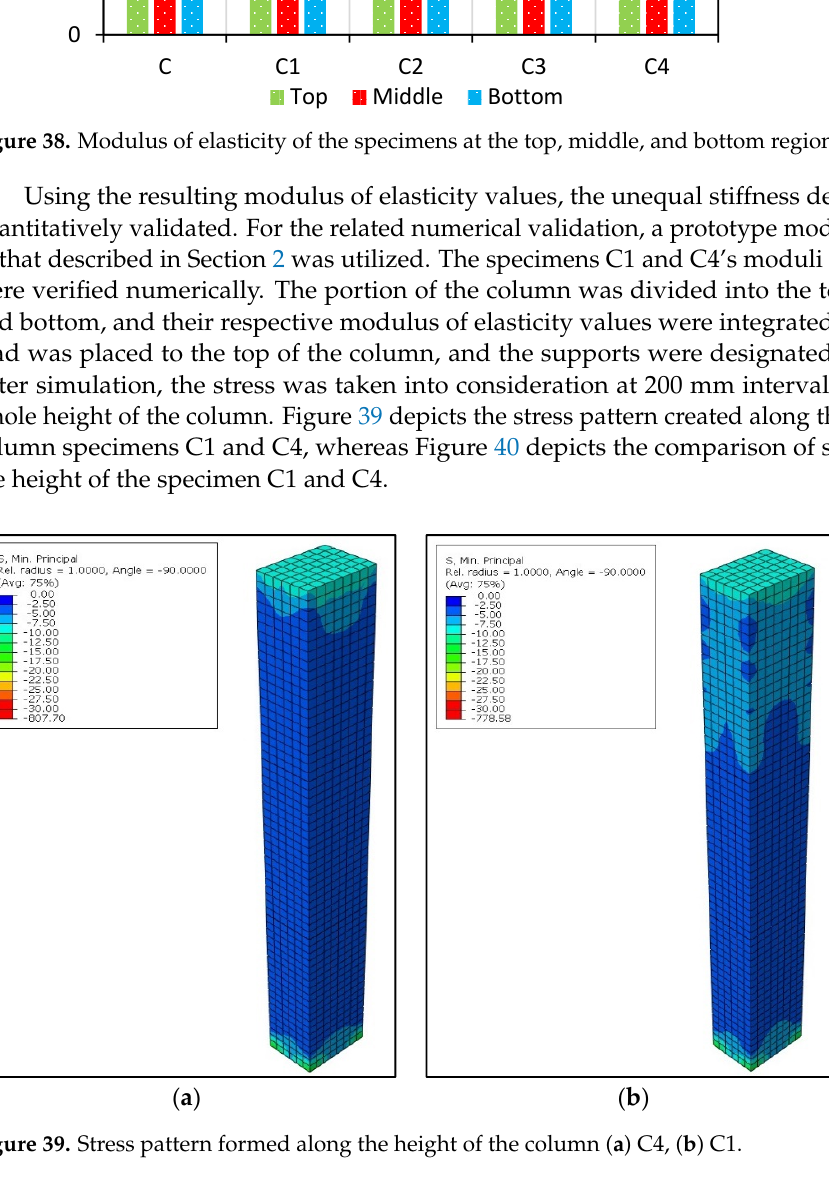
Figure 40. Comparison of stress along the height of the column. Specimen C4 shows stress that is nearly consistent over the entirety of its central re- gion. The specimen C4 experienced less stress than the specimen C1. This validates the impact of homogeneous column stiffness across its height. The stability of the mimicked column (C4) during high fire conditions is ensured by its lower stress intensity than that of the conventional column (C1). This might save the building from a catastrophic fire without any extensive fire-resistant measures. 6. Conclusions